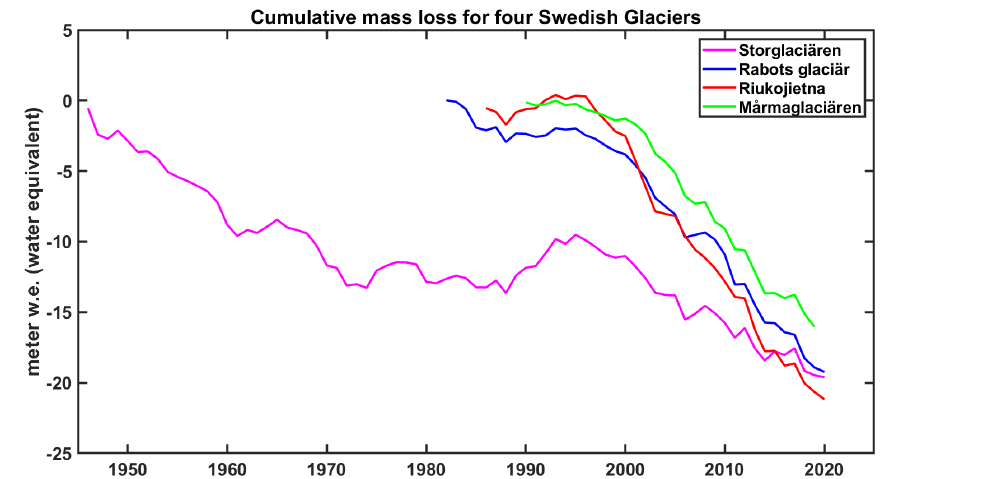
Figure 12. Cumulative mass loss for four Swedish glaciers, i.e. Storglaciären (since 1946), Rabots glaciär (since 1982; no data for 2004 and 2007 and, hence, interpolated), Riukojietna (since 1986; data for 2004 interpolated), and Mårmaglaciären (since 1990; no data for 2020). Data source: SITES data portal at https://data.fieldsites.se/portal/ (last access: 10 February 2022); World Glacier Monitoring Service, 2021; Swedish Infrastructure for Ecosystem Science, 2021a, b,